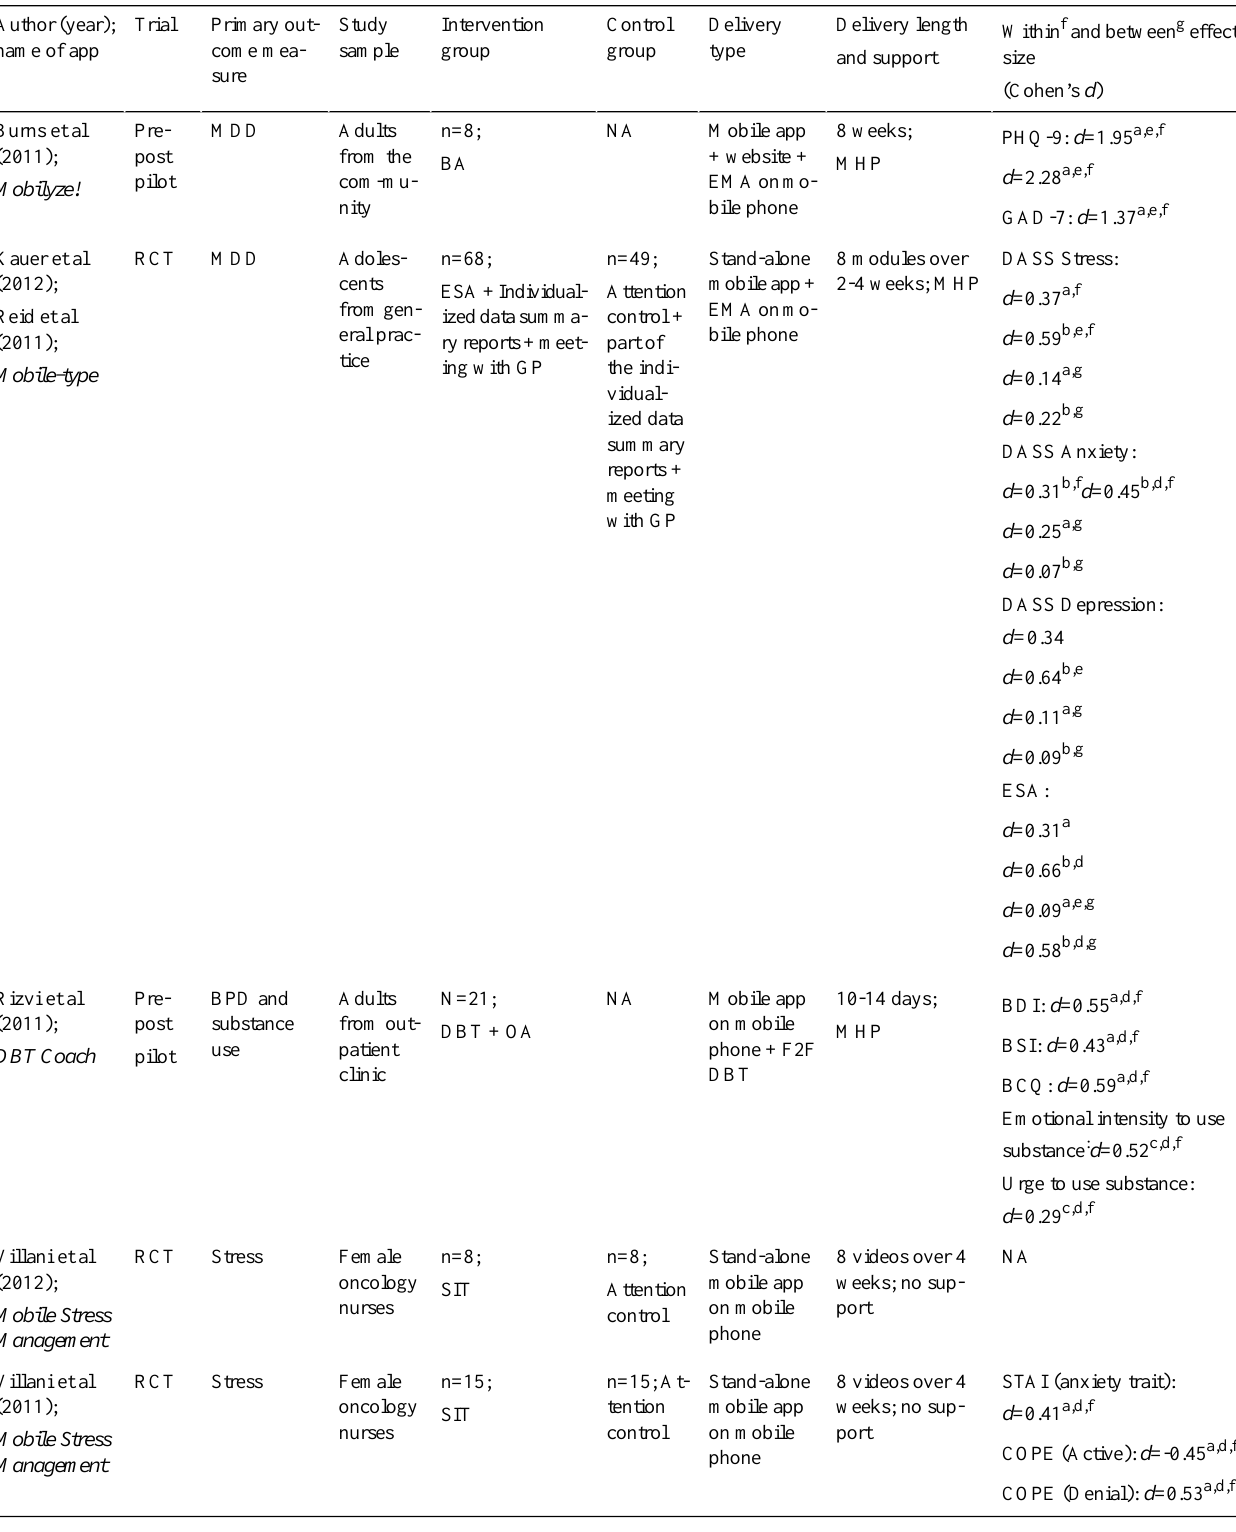
Table 1. Psychosocial studies of applications on mobile devices (Intention-To-Treat). App: Application; BA: Behavioral Activation; BCQ: Behavior Confidence Questionnaire; BDI: Beck Depression Inventory; BPD: Borderline Personality Disorder; BSI: Brief Symptom Inventory; COPE: COPE Inventory; DASS: Depression, Anxiety, and Stress Scale; DBT: Dialectical Behavior Therapy; ESA: Emotional Self Awareness; F2F: Face-to-Face; GAD-7: Generalized Anxiety Disorder-7 item scale; GP: General Practitioner; It: Italian; K10: Kessler Psychological Distress Scale-10 item scale; MDD: Major Depressive Disorder; MHP: Mental Health Professional (psychologist or psychotherapist, GP); MINI: Mini-International Neuropsychiatric Interview; NA: Not Applicable; OA: Opposite Action; PHQ: Patient Health Questionnaire; QIDS-C: Quick Inventory of Depression Symptoms-Clinician Rated; RCT: Randomized Controlled Trial; SIT: Stress Inoculation Training; STAI: State-Trait Anxiety